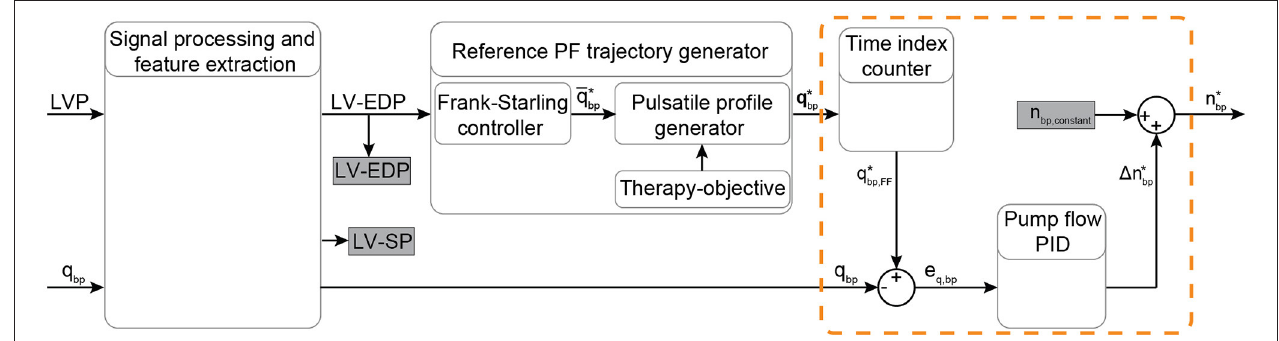
FIGURE 5 | Schematic overview of the physiological flow PID controller. The input signals LVP and PF are filtered and the EDP and SP indices are extracted from the LVP. Based on the Frank-Starling mechanism, the average PF is calculated based on the LV-EDP that is used as a preload surrogate, and the reference pulsatile PF trajectory is obtained based on the objectives of the therapy. A time index counter operates continuously to extract and output the feedforward PF setpoint at every time step. A PID flow controller (included in the orange dashed-line box) provides the necessary change in the pump speed setpoint based on the error between the measured and the desired PF. The desired pump speed is the output of the controller. Bold letters define vectors. LVP, left ventricular pressure; EDP, end-diastolic pressure; SP, systolic pressure; PF, pump flow; PID, proportional-integral-derivative; q bp , measured pump flow; ¯ q * bp , heart cycle average pump flow; q * bp , time vector of the desired pump flow trajectory; q * bp , FF , feed forward desired pump flow; e q , bp , feedback error between the measured and the desired PF; ∆ n * bp , desired pump speed change; n bp , constant , pump speed constant; n * bp , desired pump speed